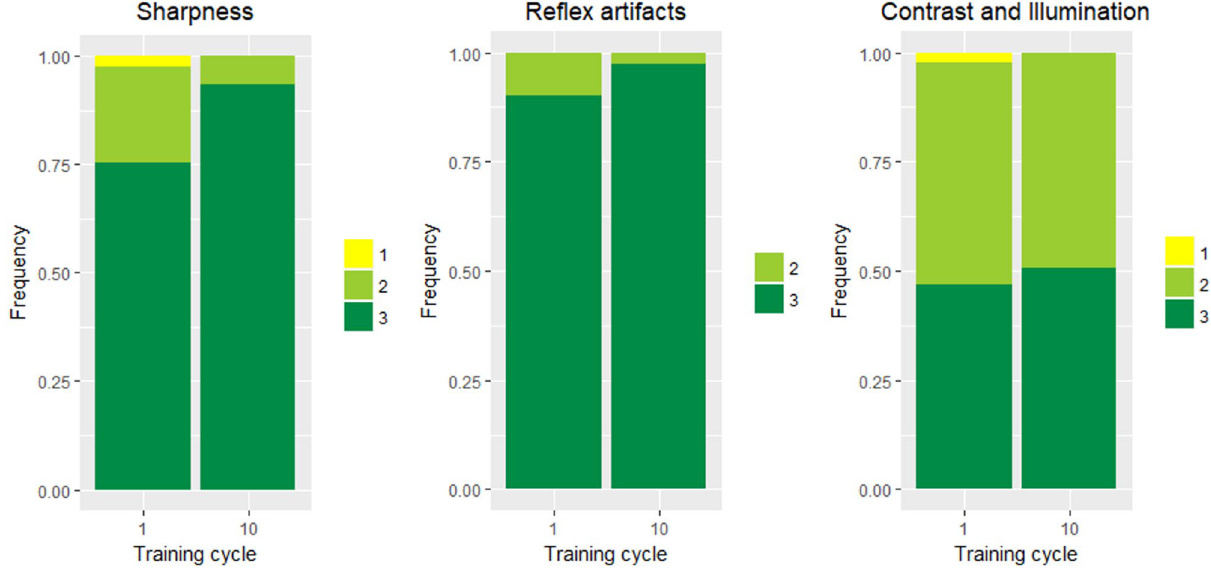
Figure 3. Effect of training on image quality in terms of sharpness/focus, reflex artifacts and contrast/ illumination. The frequencies of image quality grades for sharpness/focus ( left ), reflex artifacts ( middle ) and contrast/illumination ( right ) are displayed for the first and last training cycle. Higher grades correspond to a better image quality (see Wintergerst MWM et al. 2020 6 for the respective semi-quantitative image quality scales which have been used for